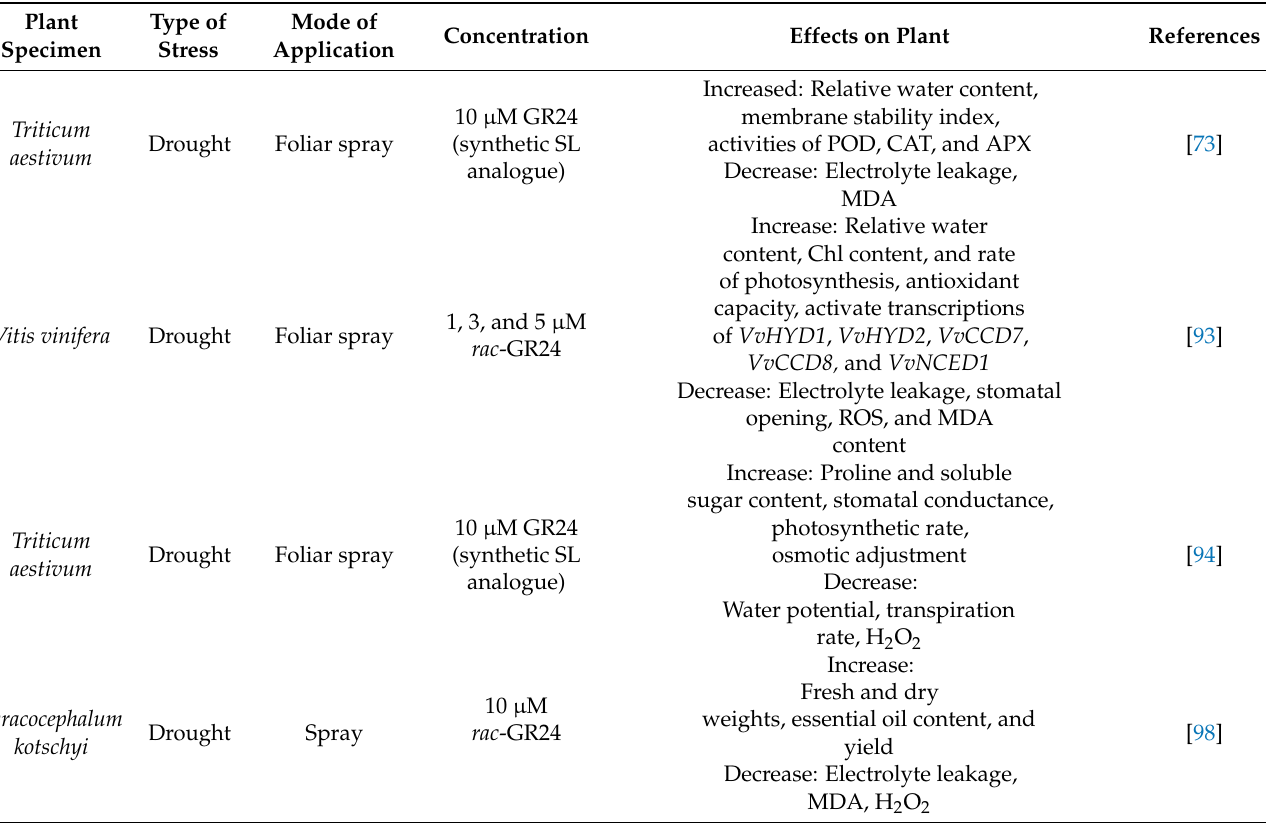
Table 1. Effects of strigolactone application at different concentrations on plant functions under abiotic stresses in various plant